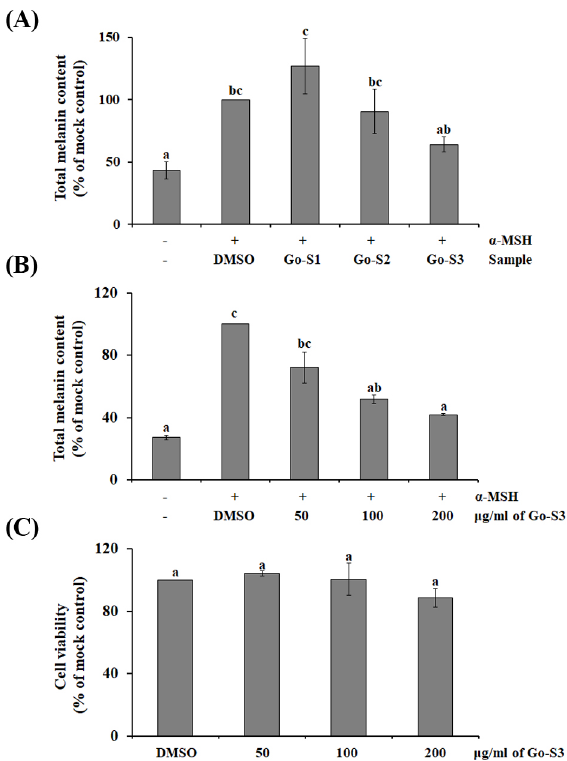
Fig. 3: Anti-melanogenic activity of Panax ginseng berry extracts. (A) Effect of Panax ginseng berry extracts on melanin production was analyzed in α-MSH-stimulated B16F10 cells. (B) Dose-dependent anti-melanogenic effects of the extract obtained from fully-ripe berries of Panax ginseng (Go-S3) in α-MSH-stimulated B16F10 cells. (C) Effect of Go-S3 on cell viability of B16F10 cells. Values are the mean ± S.E. of triplicate experiments. Bars in the same sub- figure with the same lowercase letter are not significantly different ( p <